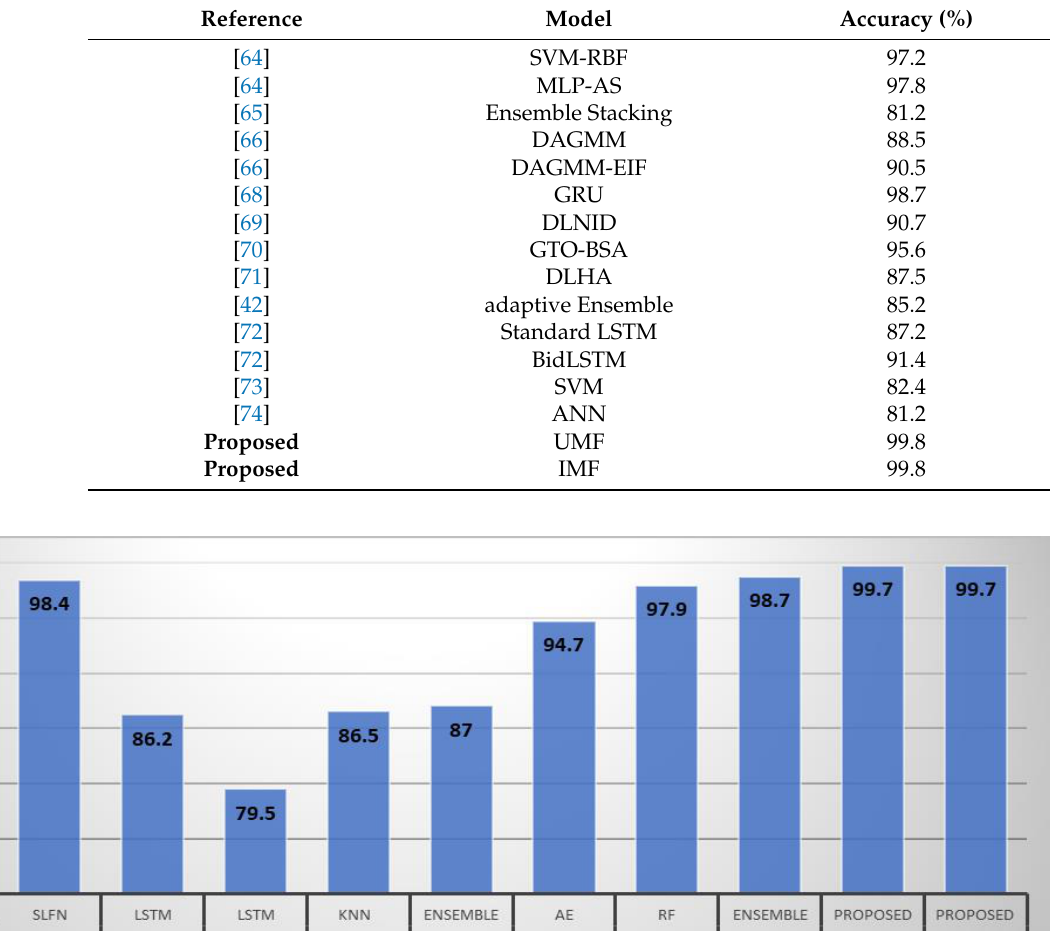
Figure 13. The comparison results of our multi classification model performance and related works of IoTID20 dataset.